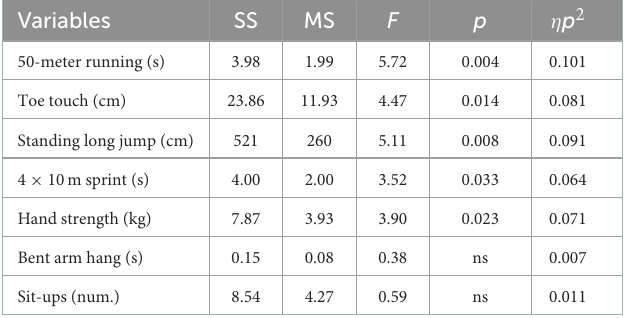
TABLE 3 Analysis of variance for physical fitness levels by group